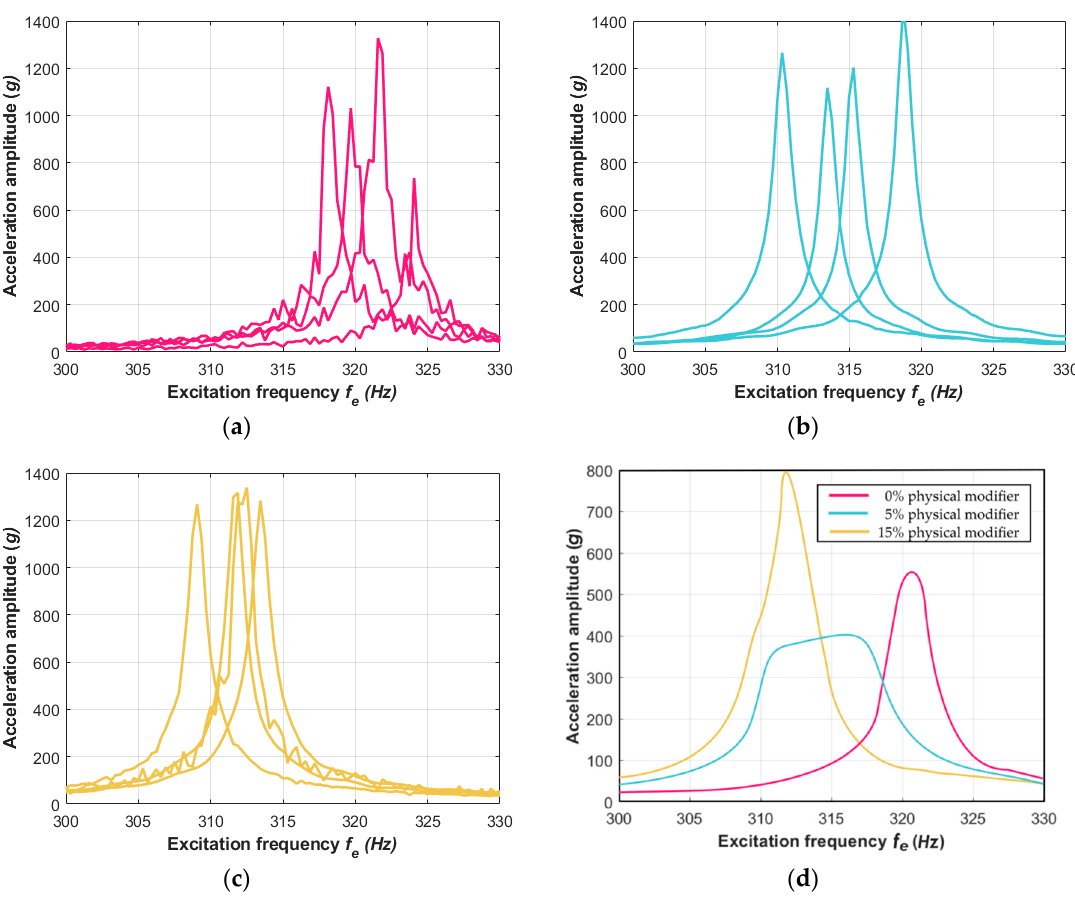
Figure 10. Second bending mode obtained from the laser vibrometer experiment of samples ( a ) without the mass share modifier and that included ( b ) 5% and ( c ) 15% of the physical modifier. ( d ) The mean values of selected characteristics for each case of each physical modifier are also